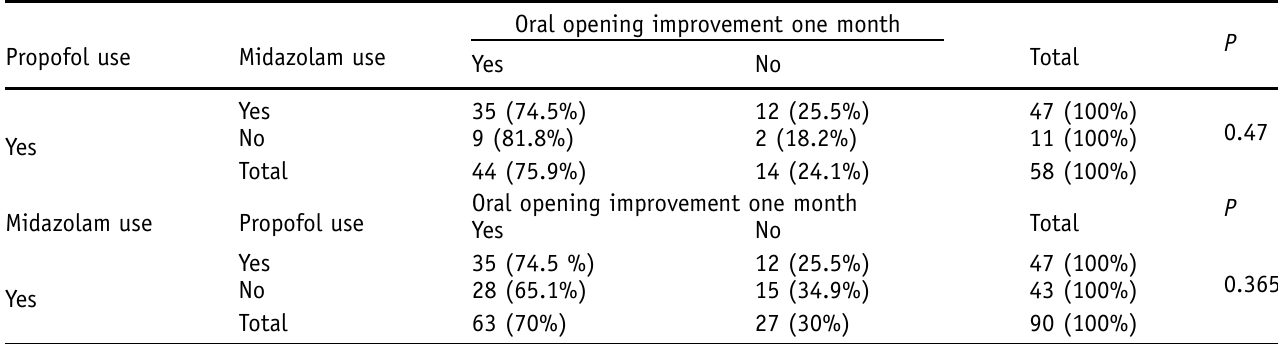
Table IV. Relationship between oral opening improvement and the use of propofol with or without midazolam and the use of midazolam with or without propofol during sedation at one month postarthrocentesis. Propofol